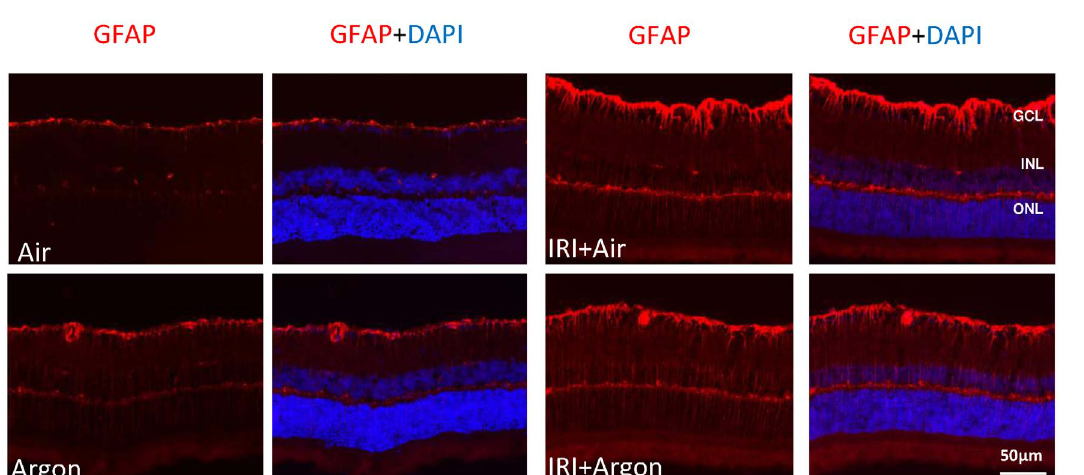
Fig. 7. GFAP expression in the retina after unilateral IRI and Argon inhalation. Cross-sections of the retinae 7 days after unilateral IRI. In controls with and without immediate Argon 75 Vol% inhalation, GFAP was only positive in Mu¨ller cells and astrocytes in the GCL. After ischemia, GFAP was upregulated in Mu¨ller cells. Their processes, extending through all retinal layers, became GFAP positive. Scale bar, 50 m